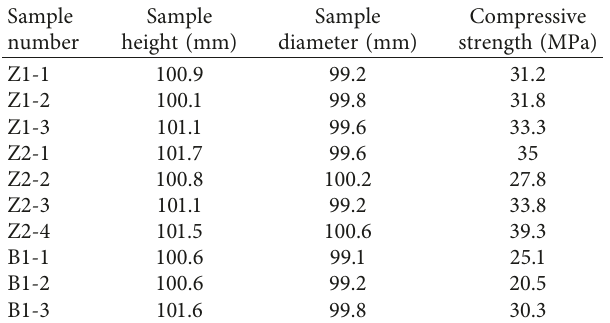
Table 3: Elastic modulus tests results of